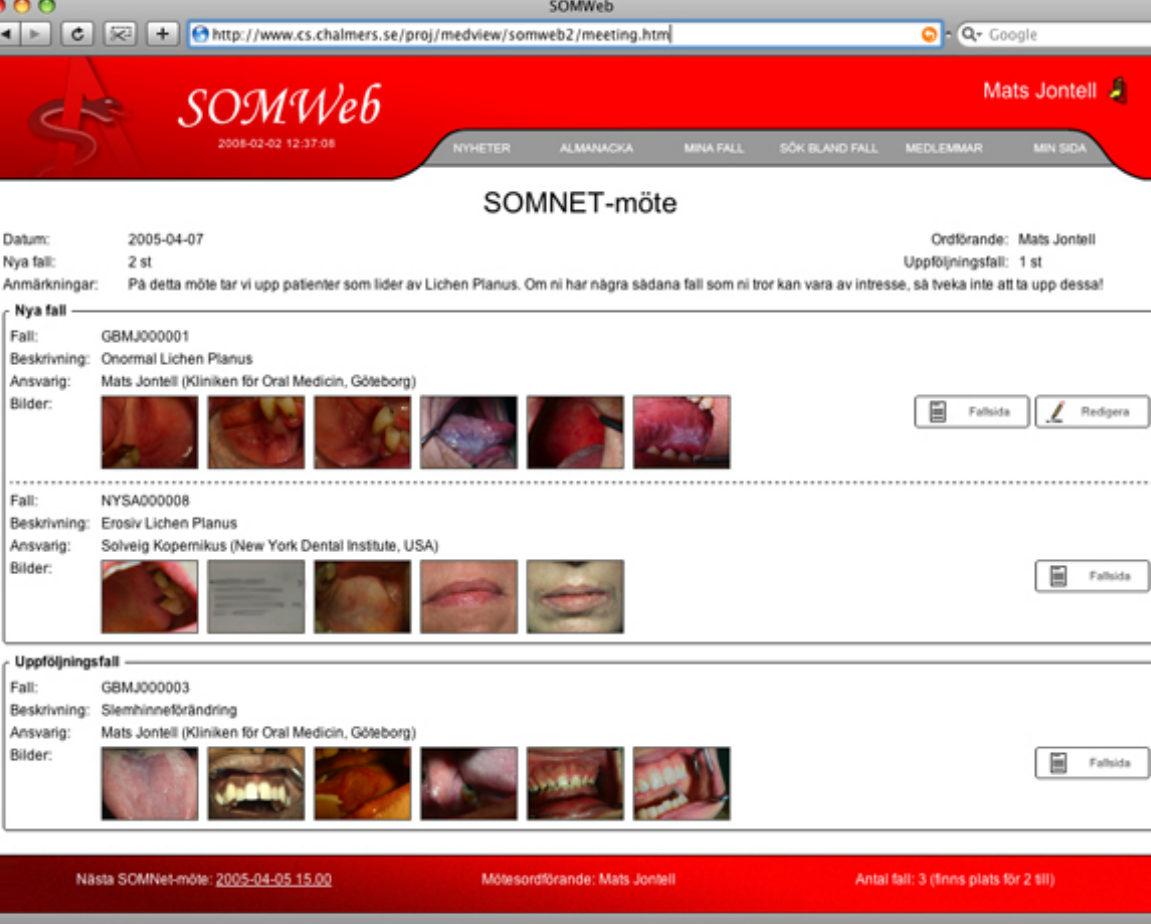
Figure 2. The first HTML prototype of SOMWeb showing a meeting page with new cases to be discussed for the first time and cases that are follow-ups from previous meetings, with photos for each case displayed as a row of